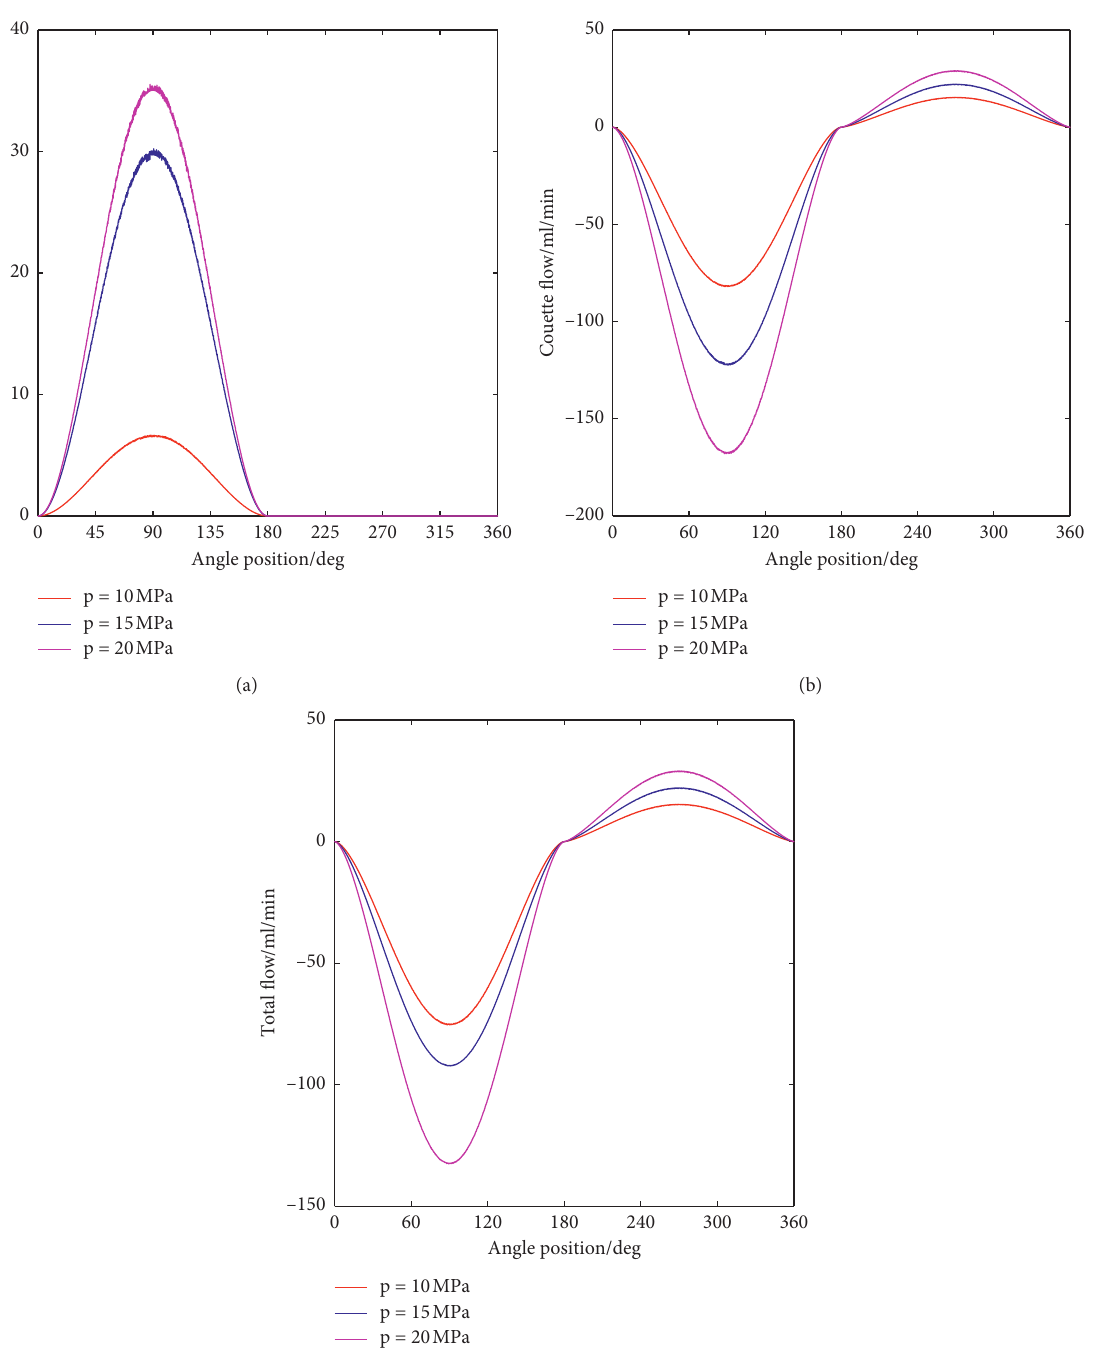
Figure 13: The leakage flow of PRCB per piston at different discharge pressures. (a) The Poiseuille flow; (b) the Couette flow; (c) the total flow